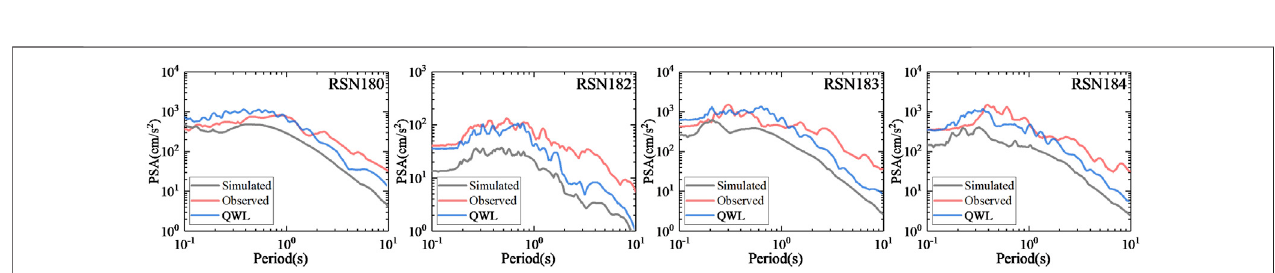
FIGURE 4 | The simulated, observed, and QWL response spectra produced by ground motion at the bedrock and at the surface of four stations that recorded seismic data from the Imperial Valley Earthquake.